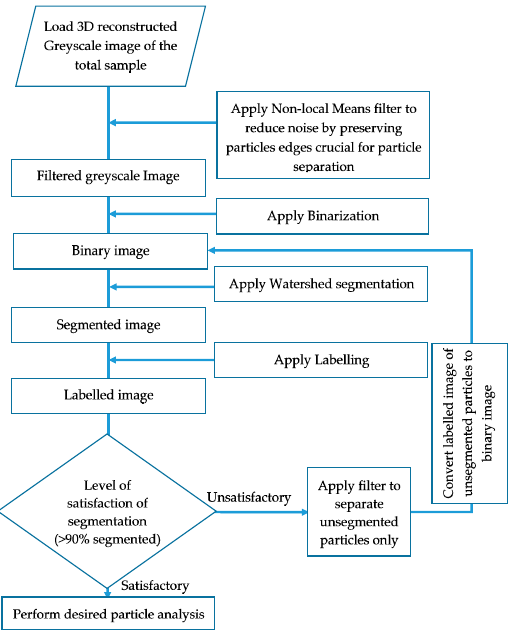
Figure 3. Flow chart depicting all operations of image processing in this study.